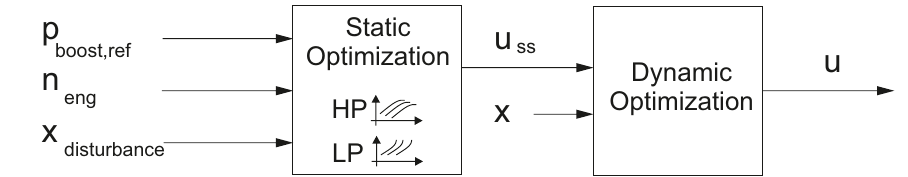
Figure 5. Control scheme for the multi-objective